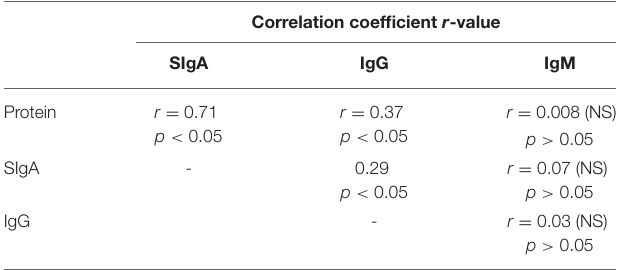
TABLE 3 | Correlations among skim milk protein and immunoglobulins during prolonged lactation. Correlation coefficient r